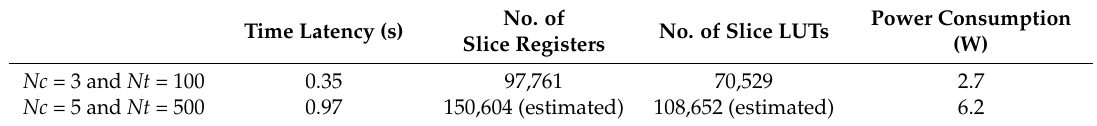
Table 4. Requirements for real-time classification of input touch